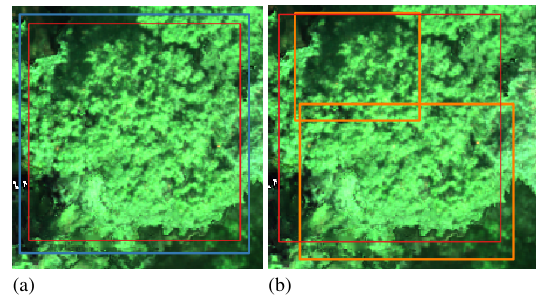
Figure 6. Sample area from mixed plot #2 showing over-segmentation. Reference bounding boxes are in red. a) Detected bounding boxes for DETR are in blue. b) Detected bounding boxes for YOLOv4 are in orange.